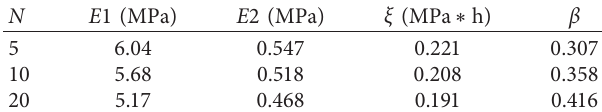
Table 2: Stress parameters of the model.